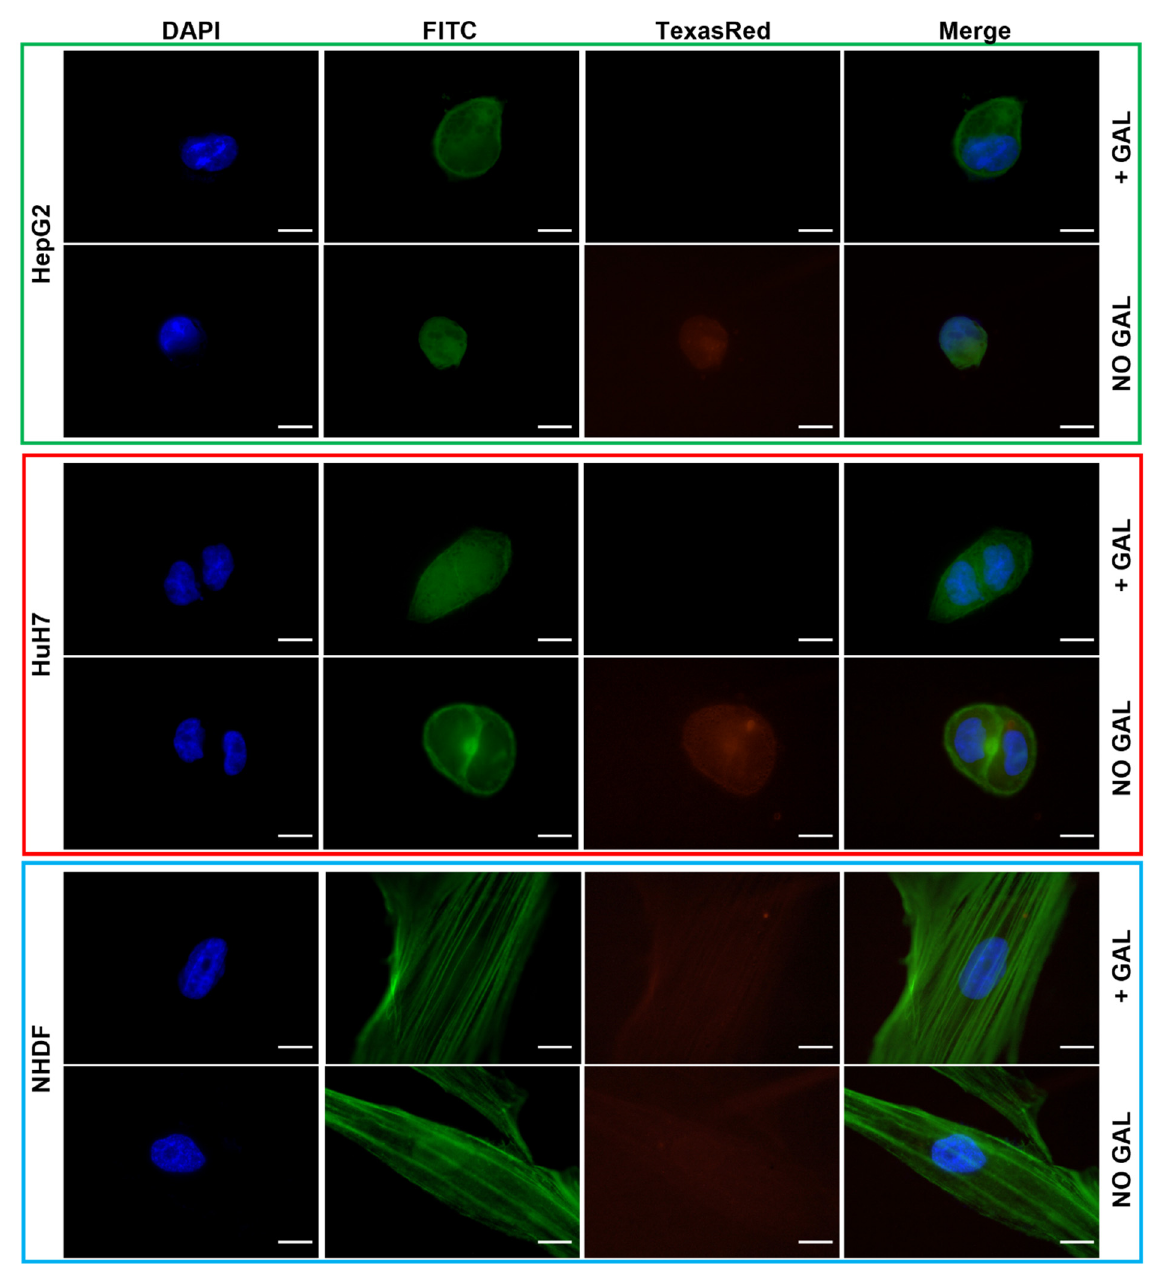
Figure 12. Uptake studies on hepatocarcinoma cell lines and fibroblasts after 24 h incubation with labelled drug empty NPs containing AuNRs-C 12 . Scale bar 10 µm.